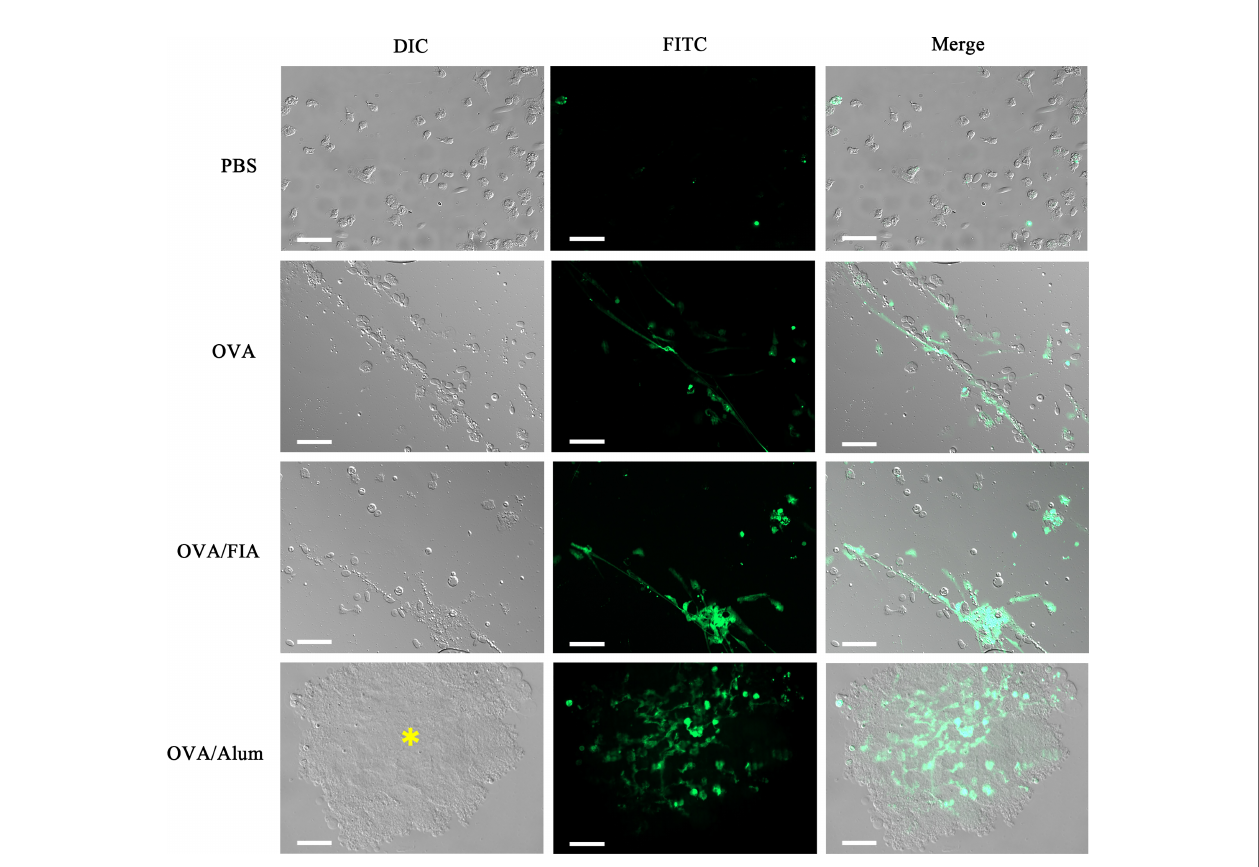
FIGURE 6 | The observation of peritoneal cells and extracellular traps (ETs) ex vivo after injection with antigen, adjuvant, or mixture. Representative images of peritoneal cells and ETs isolated from individuals injected with antigen, adjuvant, or mixture after 12 h and dyed with Sytox Green. Arrows indicate the presence of ETs. Asterisk represents Alum and Alum-attracted peritoneal cell mass. Scale bars, 20